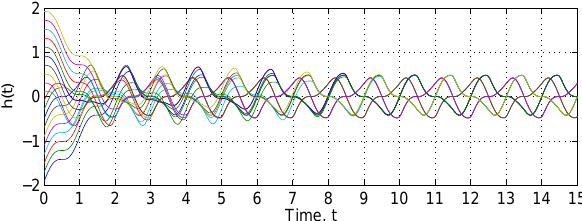
Fig. 8. Multiple stable solutions. Twenty trajectories that corre- spond to different initial histories φ(t) ≡ φ 0 collapse, after a tran- sient, onto four stable solutions. Two of these solutions are distinct and the other two can be obtained from the latter by a time shift.